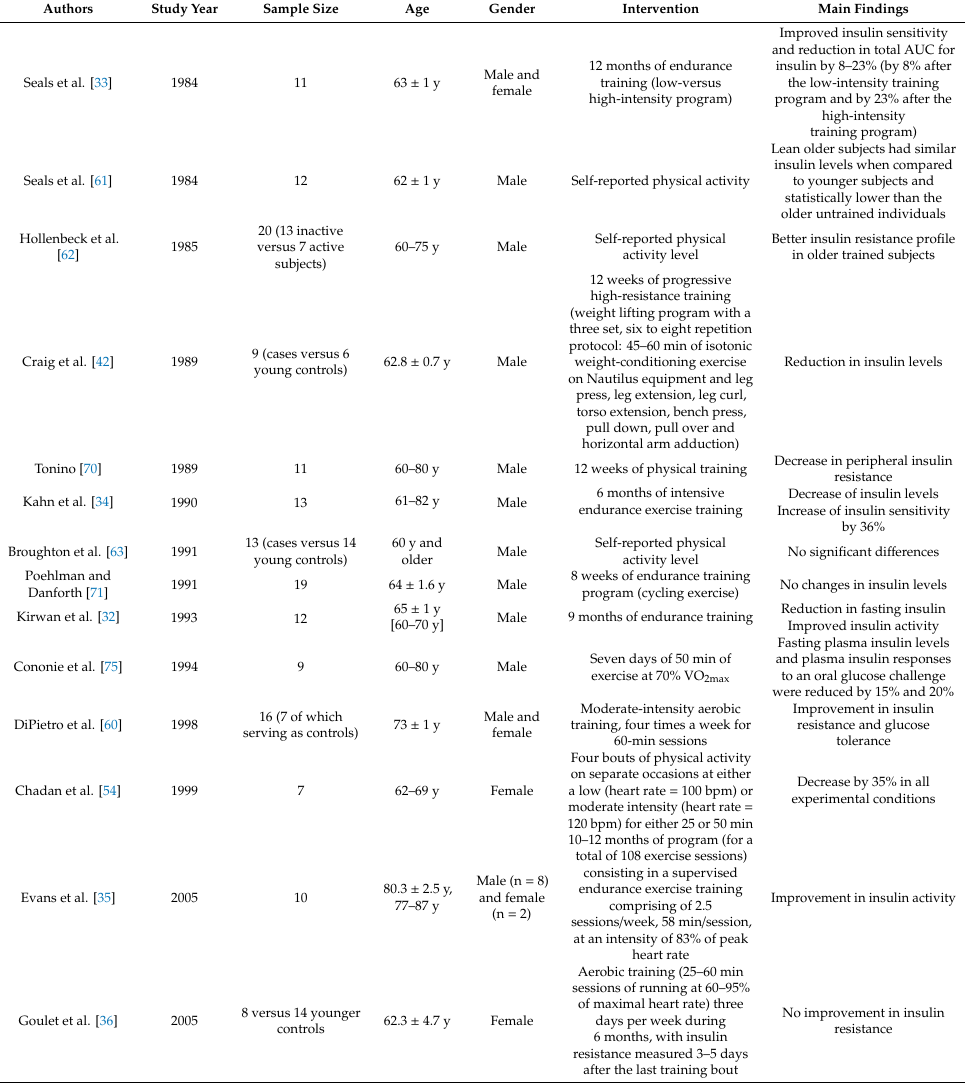
Table 2. Studies investigating the e ff ects of physical activity and exercise on insulin in elderly subjects. Authors StudyYear SampleSize Age Gender Intervention MainFindings